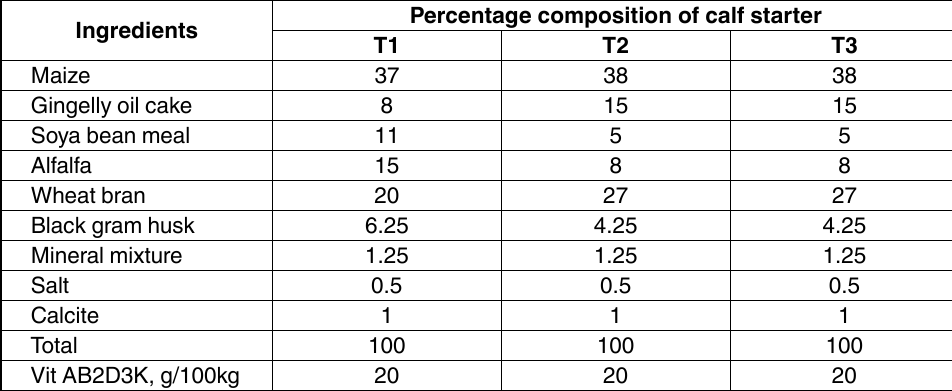
table 1. Ingredient composition of calf starter offered to calves maintained on three dietary treatments. ingredients Maize Gingelly oil cake